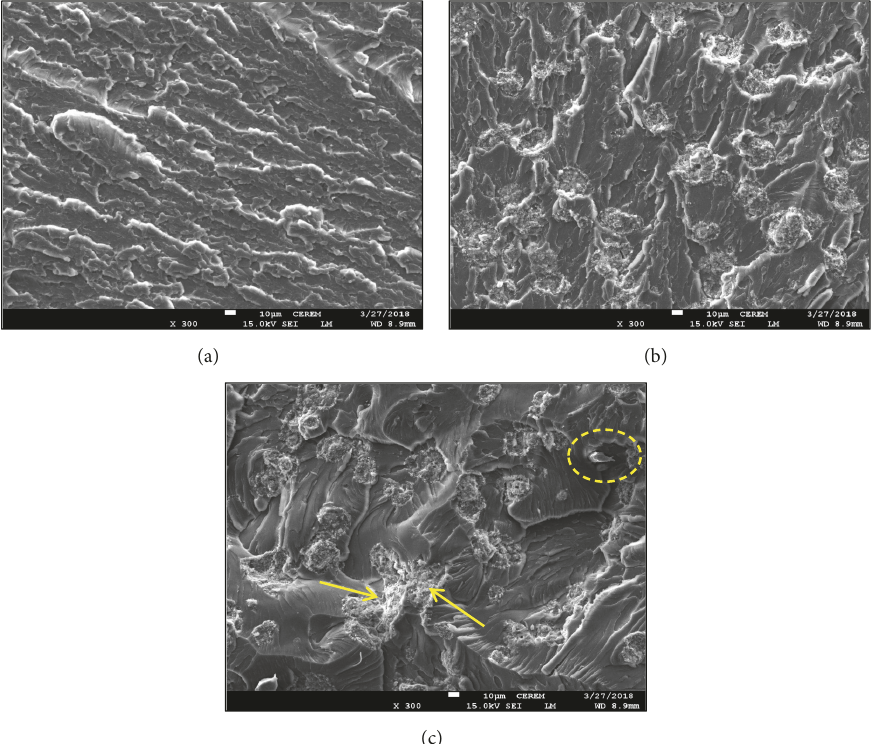
Figure 9: SEM micrographs of tensile-fractured surface of (a) neat polyester; (b) composites with 5 vol% of alumina; and (c) composites with 10 vol% of